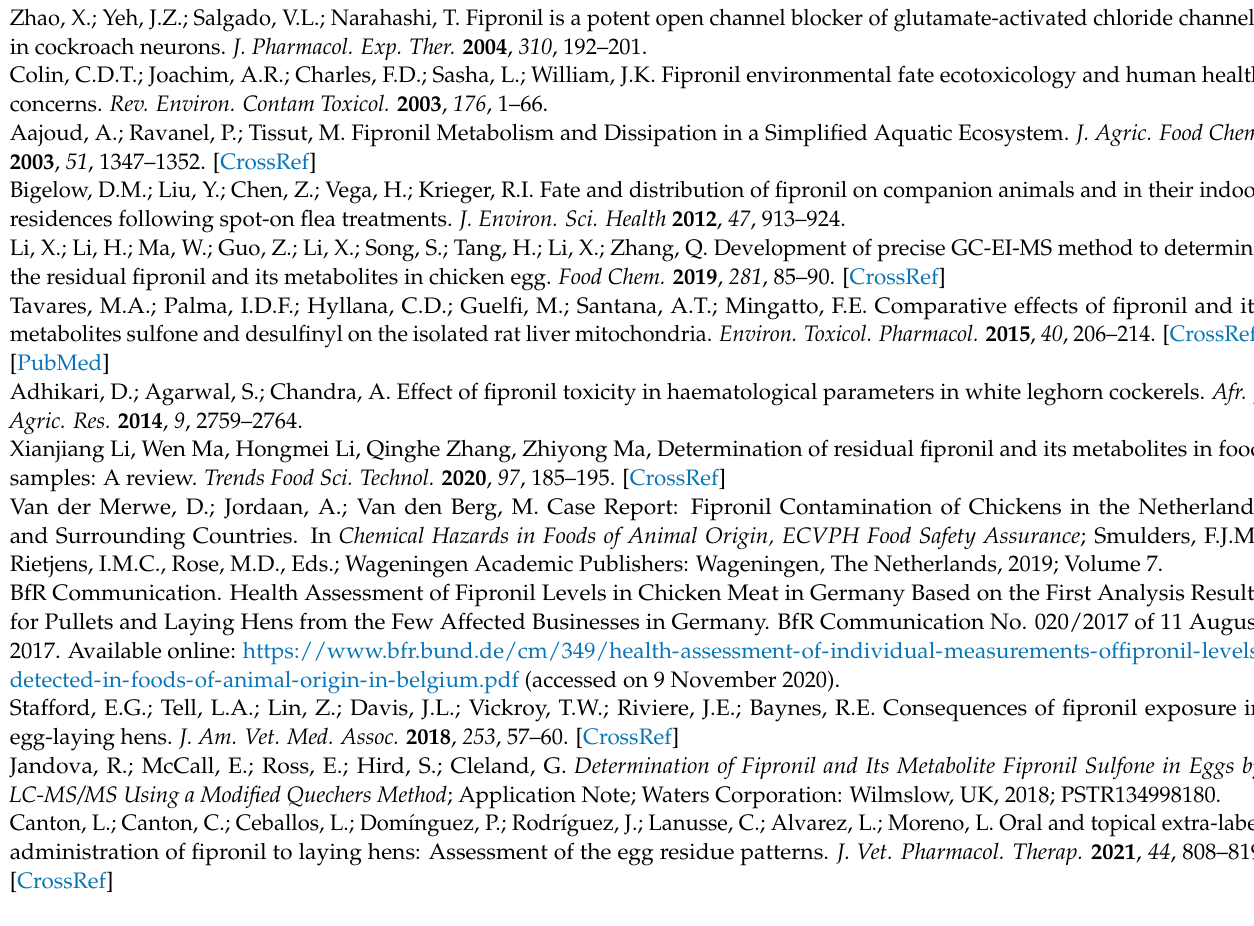
MS/MS method, Table S2: Regression equation and r 2 of the active ingredients, Table S3: Intra-day repeatability and inter-day reproducibility of fipronil and fipronil sulfone concentrations in eggs and feathers, Figure S1: MRM chromatogram of fipronil and fipronil sulfone in egg sample after oral exposure, Figure S2: MRM chromatogram of fipronil and fipronil sulfone in feathers samples after oral (A) and dermal (B)